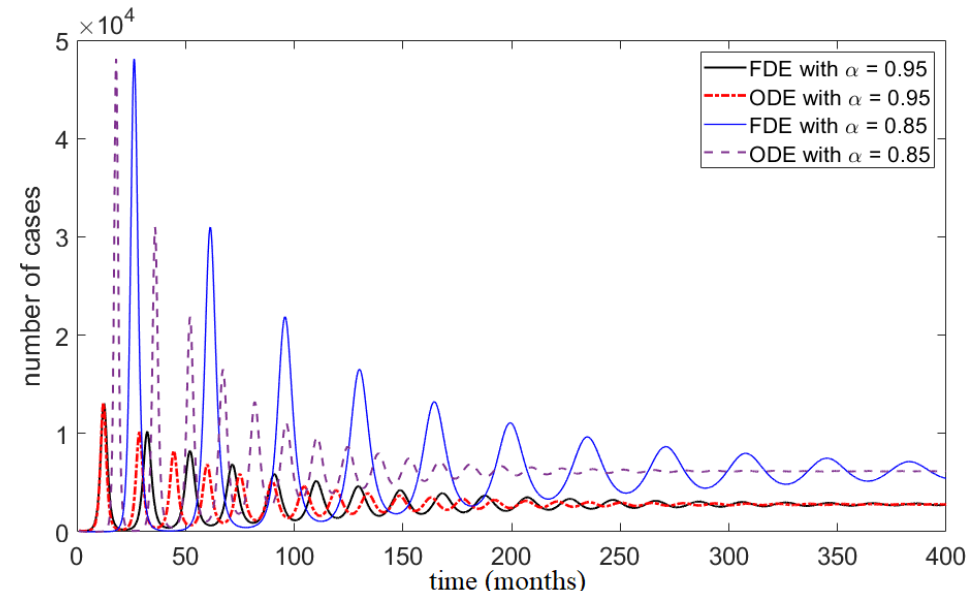
Figure 3. Number of cases using FDE model and its analogous α -dependent ODE with different fractional orders α . The simulations are done using µ (cid:63) = 0.0027, β (cid:63) = 119.2257, δ (cid:63) = 16.7301, and σ (cid:63) = 10.1873.